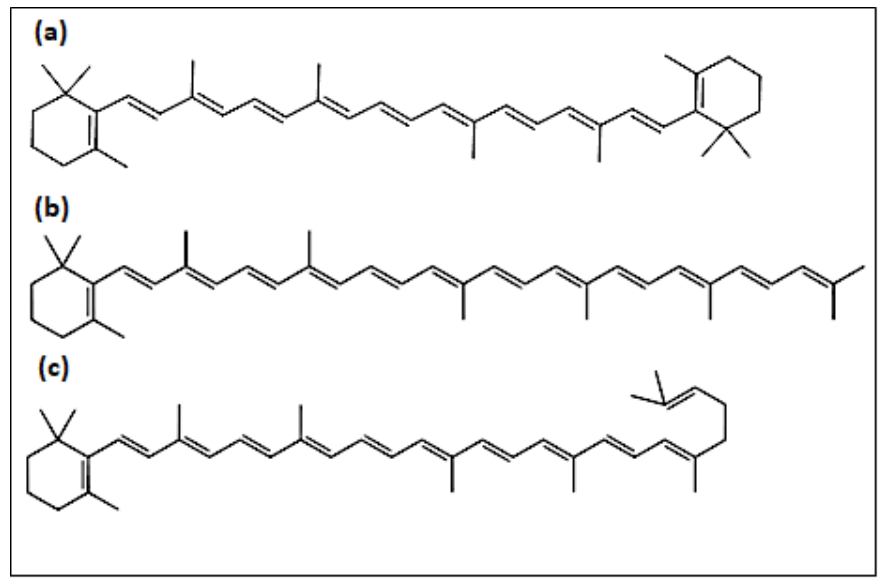
Figure 3. Chemical structure of main carotenoids produced by R. glutinis P4M422: ( a ) β‐ carotene, ( b ) torulene, and ( c ) γ‐ carotene. ( b ) torulene, and ( c ) γ